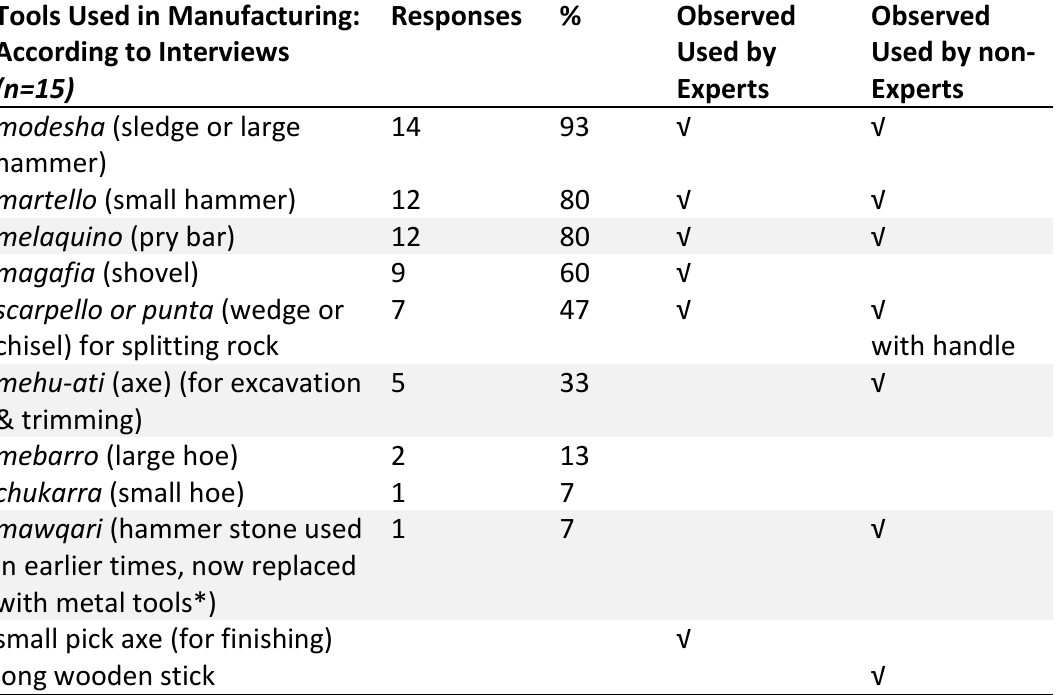
Figure 6. Men applying leverage with a pry bar to extract the boulder during excavation. Table 2. List of tools. *The metal tools have taken on Italian terms for the Tigrinya speaking people of this region. It is likely that these tools were introduced by the Italians who have had a long presence in Ethiopia. - In the second manufacturing process with the non-experts, we did observe stones being used for some processing and smoothing of the surfaces. It could be that they did not have the necessary metal tools because they were not